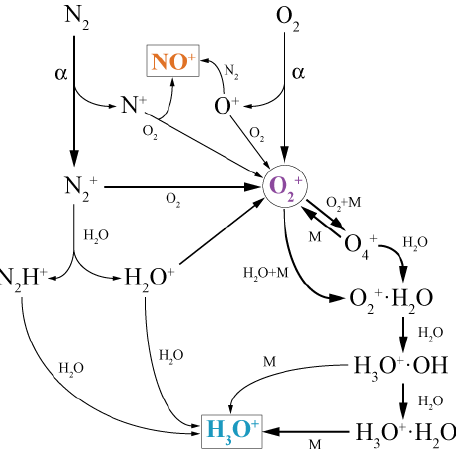
Fig. 4. Schematic showing the principal ionization pathways for the production of H 3 O + from α -particle ionization of ambient air. x +M indicates a three-body reaction, M indicates a declustering collision. The arrows indicate the flow of charge through the reac- tion mechanism.